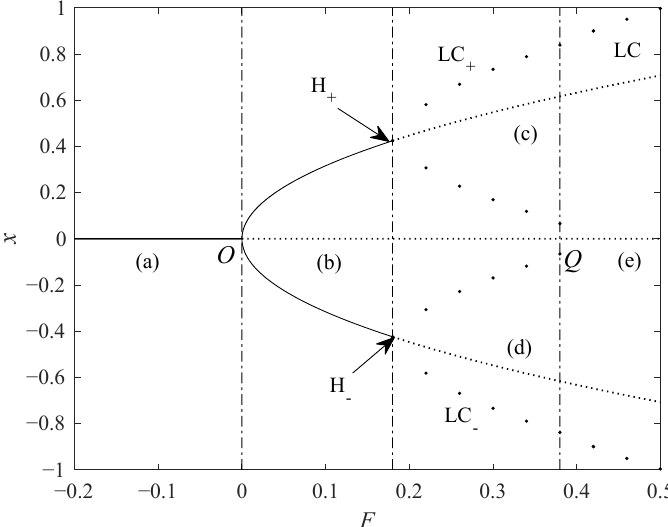
Figure 7. Bifurcation diagram of Equation (3) for 1.28 q .